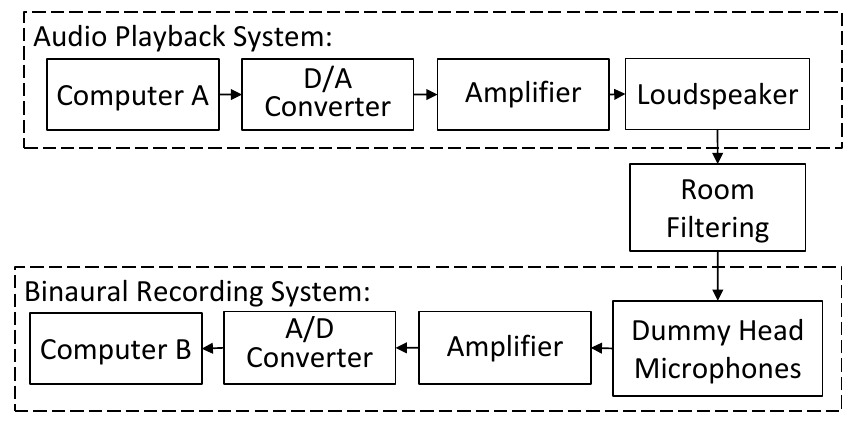
Figure 10. The experiment outline: The audio playback system and binaural recording